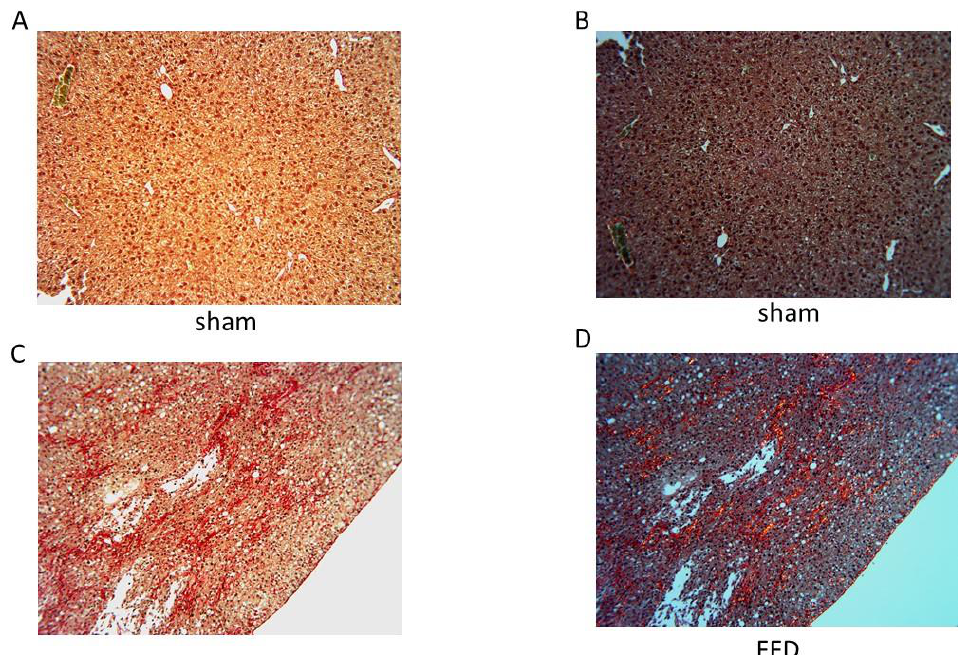
Figure 4. Collagen Deposition in NASH with Fibrosis. Representative images (10×) of a PSR-stained liver section from a mouse randomized to a standard diet under brightfield ( A , 10×) or circularly polarized light ( B ). Representative images (10×) of a PSR-stained liver section from a mouse randomized to FFD under brightfield ( C , 10×) or circularly polarized light ( D ) exhibiting yellow-orange birefringence.